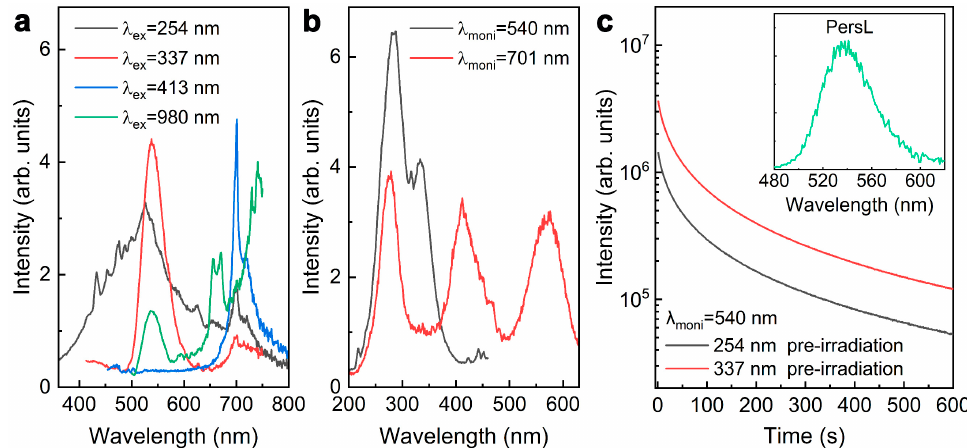
Figure 4. Excited wavelength-dependent fluorescence characteristics of Zn 2.4 Li 0.6 Ga 2 GeO 8 :Mn phosphors prepared by hydrothermal approach. ( a ) PL spectra under various selective excitation and PSL upon 980 nm laser diode (0.5 W) irradiation; ( b ) Excitation spectra monitoring at 540 and 701 nm; ( c ) PersL decay curves (monitoring at 540 nm) after irradiation by using 254 nm or 337 nm light for 5 min, the inset is the PersL emission spectrum achieved at 7 s of the decay.